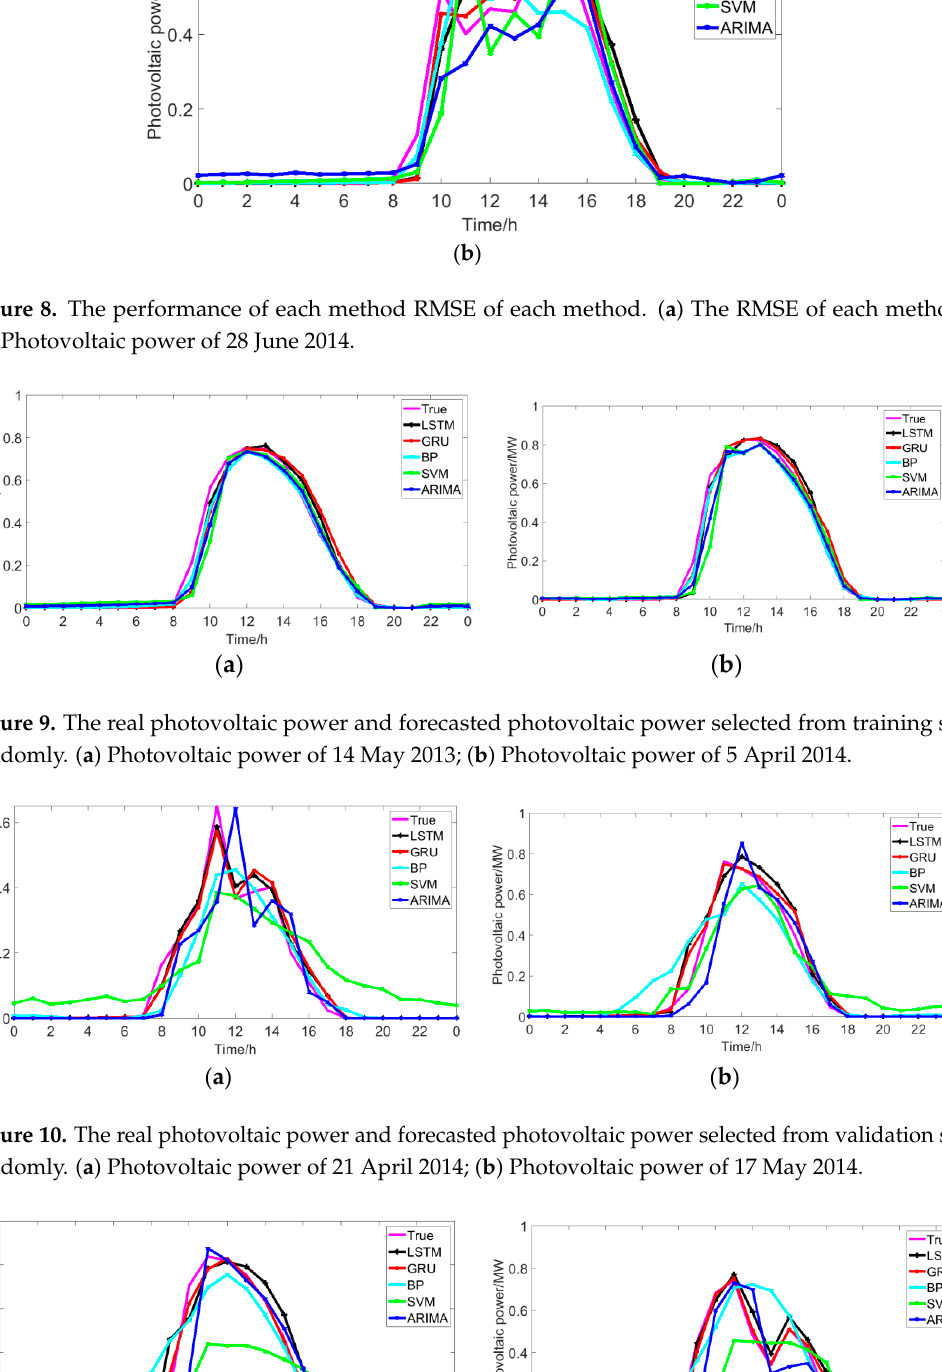
Figure 11. The real photovoltaic power and forecasted photovoltaic power selected from test set randomly. ( a ) Photovoltaic power of 17 June 2014; ( b ) Photovoltaic power of 23 June 2014.